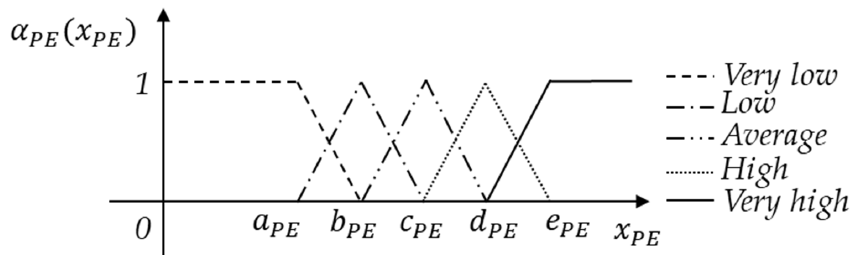
Figure 5. The membership function of the linguistic variable in the effectiveness of the processing system.